Question: What direction does the quantity move in — increasing or decreasing?
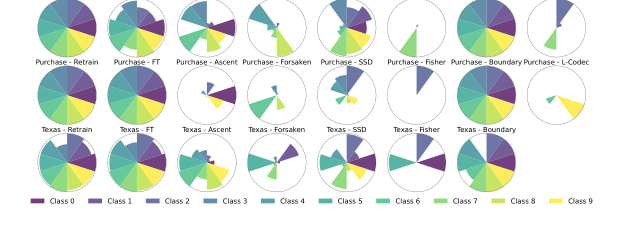
Answer: increasing